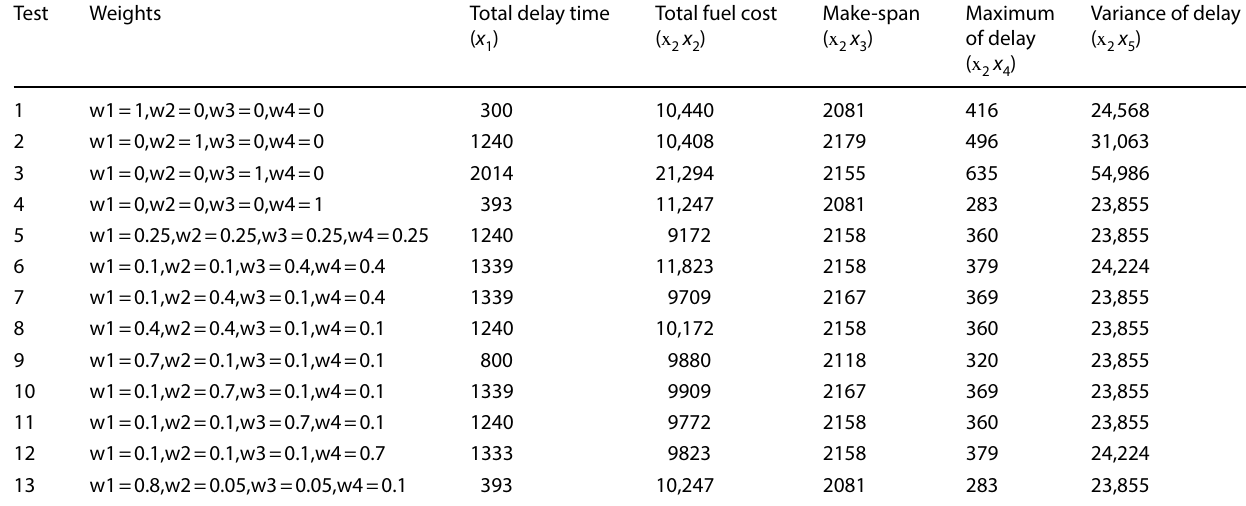
Table 5 Using SA to calculate the performance indicators when the weights take the following value